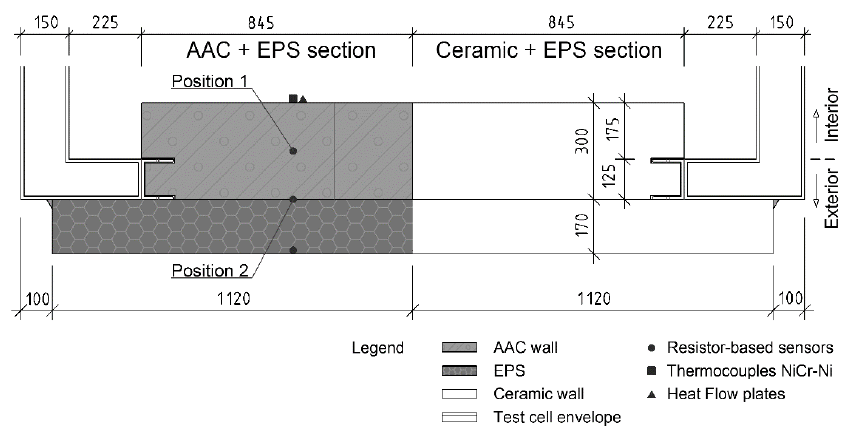
Figure 2. Configuration of the wall of the test cell and the position of the measuring sensors. Section view of the AAC section [28,29].